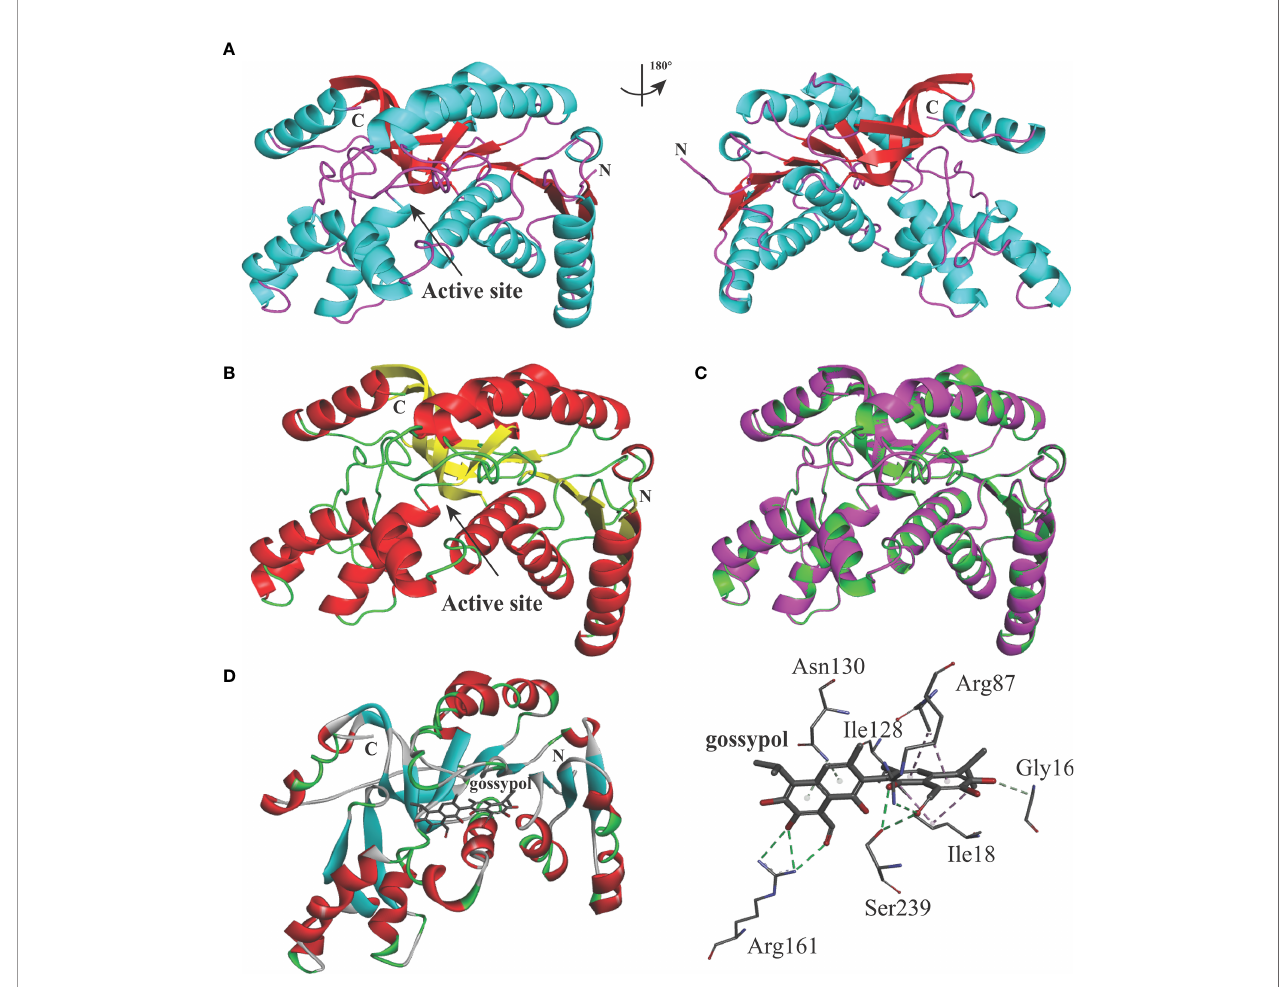
FIGURE 2 | Structure models of B. bigemina LDH. (A) The 3D structure model of B. bigemina LDH. The 3D model was constructed by using SWISS-MODEL based on the reported apo BoLDH (7w8a). (B) BoLDH crystal structure. The structure of apo BoLDH was displayed as the cartoon, and the active pocket was labeled. (C) Structural comparison between apo BoLDH and BbigLDH (1t2d). BbigLDH (green) was superimposed on BoLDH without ligands (magenta). (D) Structural cartoon of BbigLDH with gossypol and oxalate on LDH catalytic pocket. The distribution of hydrogen bonds and hydrophobic interactions at the gossypol interface are shown. The interacting amino acids in the NADH binding pocket are labeled and shown as stick diagrams, and the dashed lines represent the hydrogen bonds and hydrophobic interactions between the respective donor and acceptor atoms. Gossypol was displayed as a stick diagram,